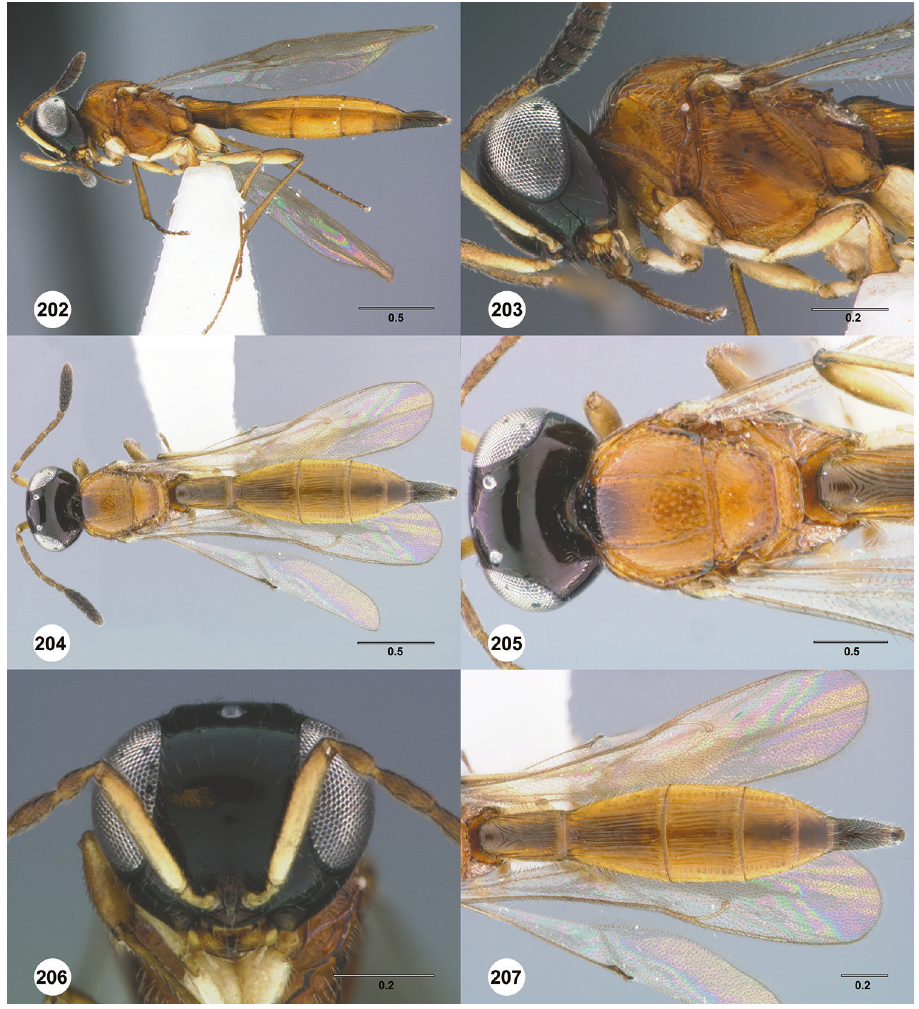
tures. Shape of metascutellum: posterior margin straight, approximately 3.0× wider than long. Sculpture of metascutellum in female: finely crenulate. Sculpture of metas- cutellum in male: finely crenulate. Dorsal propodeum in female: shallowly excavate medially, with lateral propodeal carinae widely separated. Sculpture of dorsal propo- deum in female: rugose. Sculpture of dorsal propodeum in male: rugose with one or two longitudinal keels lateral median keel. Median keels on propodeum in female: absent. Mesopleural carina: present. Sculpture of mesepisternum below mesopleural depression: smooth. Sculpture of ventral metapleural area: smooth. Color of